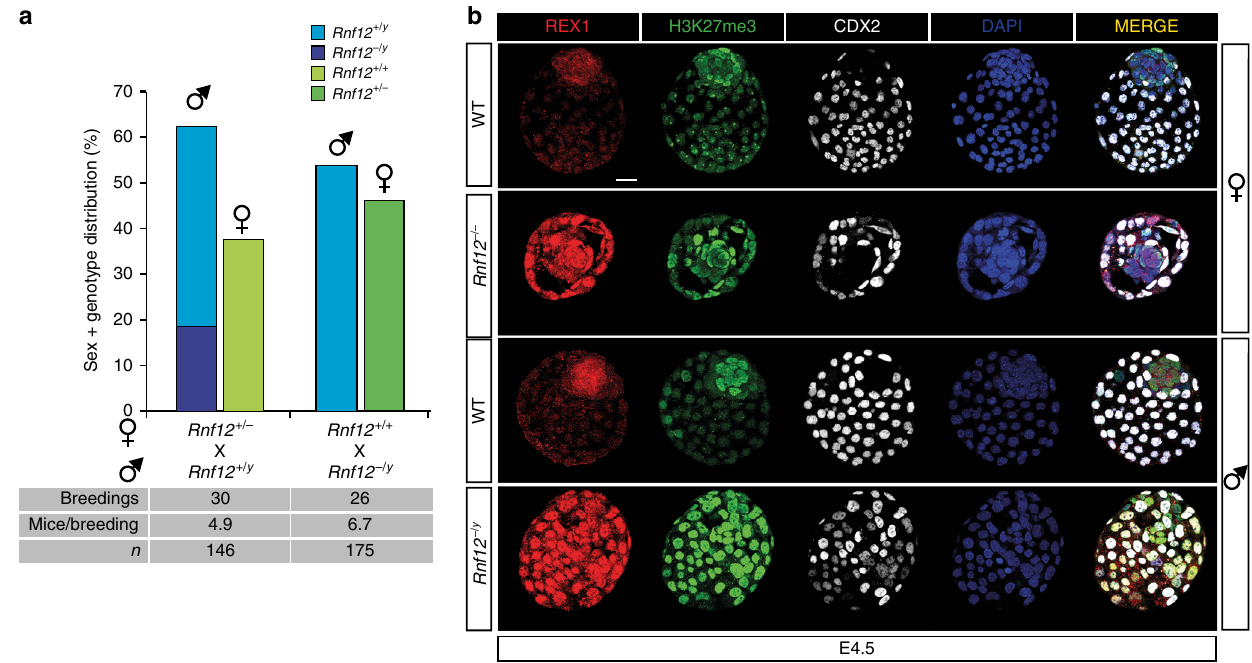
Fig. 4 Rnf12 KO embryos show REX1 stabilization in embryonic and extraembryonic tissues. a Sex and genotype distribution from different matings of Rnf12 -de fi cient mice in a C57BL/6 background. Number of breedings, number of mice per breeding and total number of mice are indicated. Note that no female embryos were born with a maternally transmitted Rnf12 deleted allele. No signi fi cant differences were observed between the number of females with a paternal mutant allele and their WT brothers ( χ 2 test, p > 0.05). A signi fi cant slight lethality associated with the mutation in male mice compared to WT brothers was observed ( χ 2 test, p = 1.05E − 4). b Representative Z -stack projections of WT, Rnf12 − / − and Rnf12 − /y E4.5 blastocysts immunostained for REX1 (red), H3K27me3 (Xi marker, green), the trophectoderm marker CDX2 (grey) and DNA (DAPI, blue). Scale bars: 20 μ